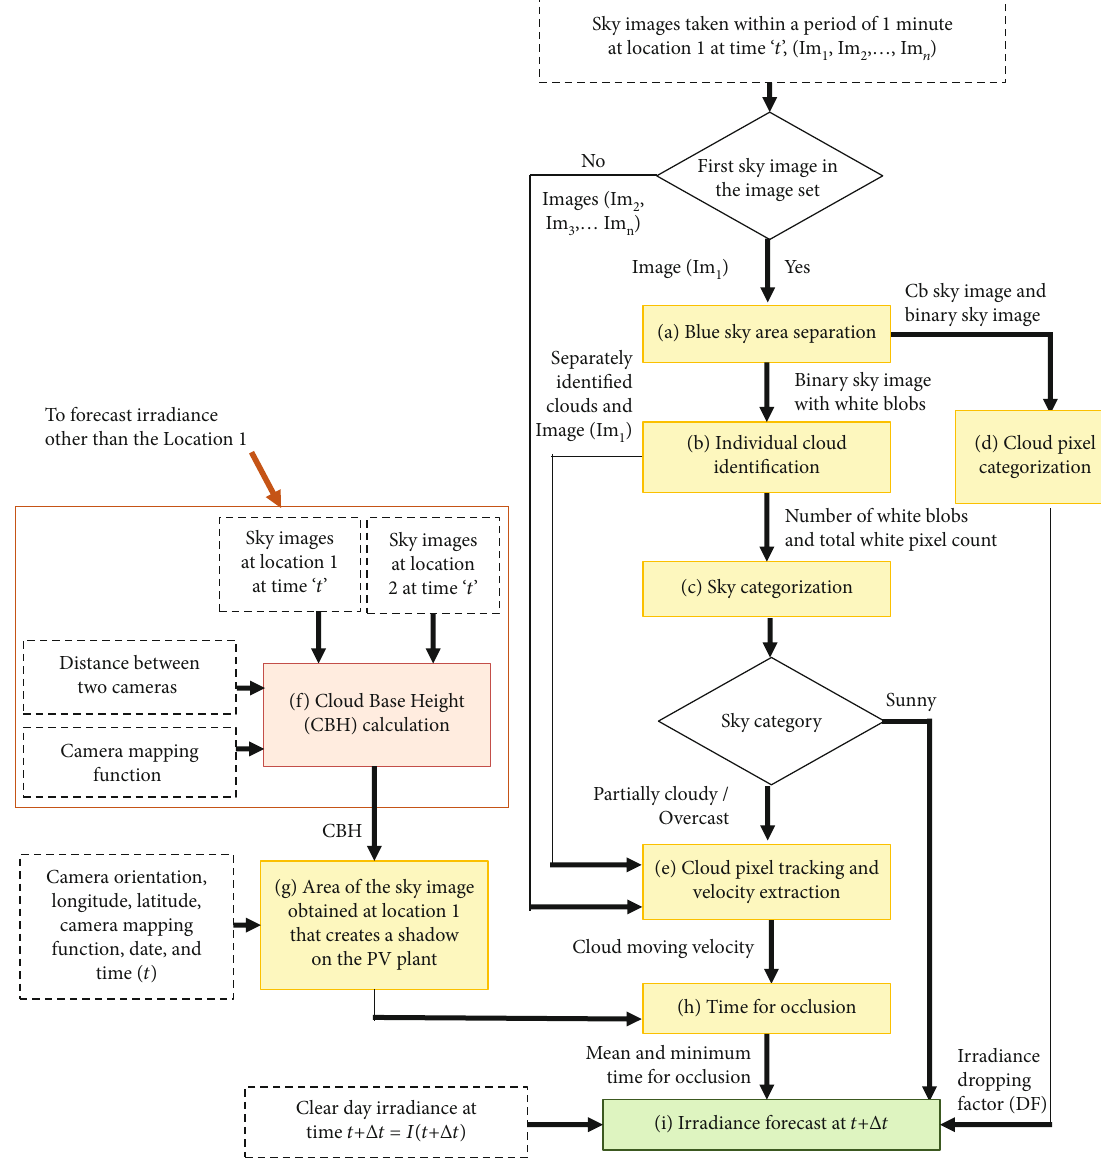
Figure 2: Irradiance forecasting